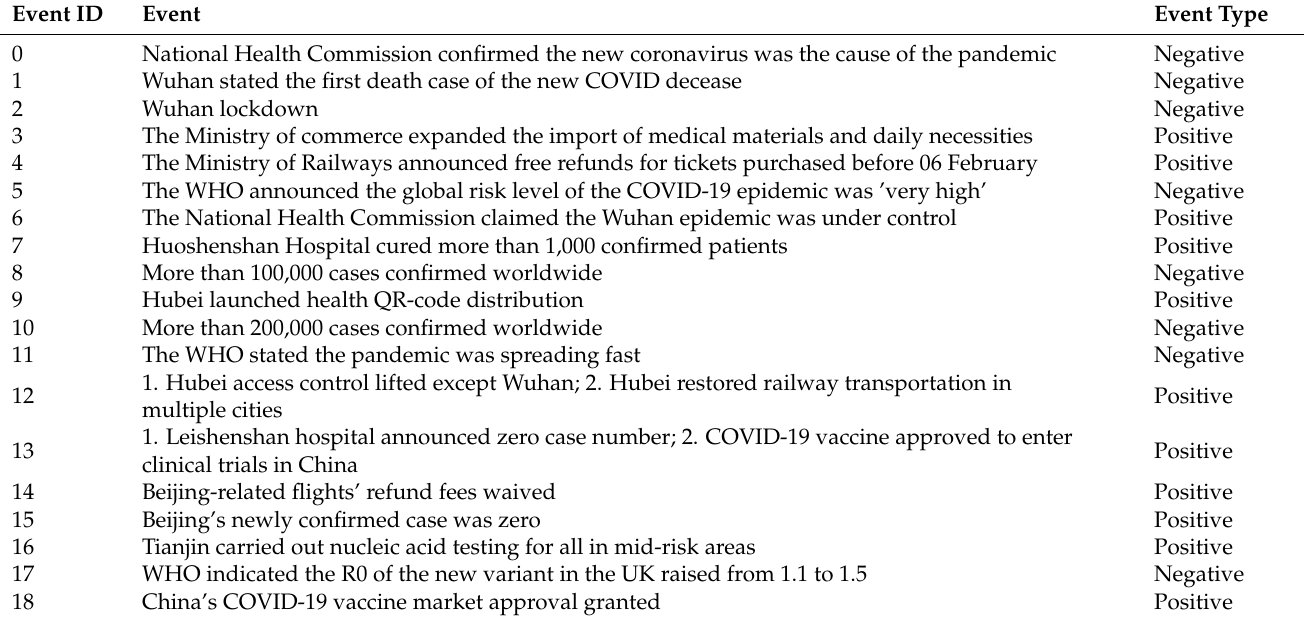
Table 2. Event ID and its detail.